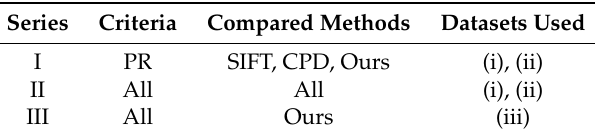
Table 1. The experimental